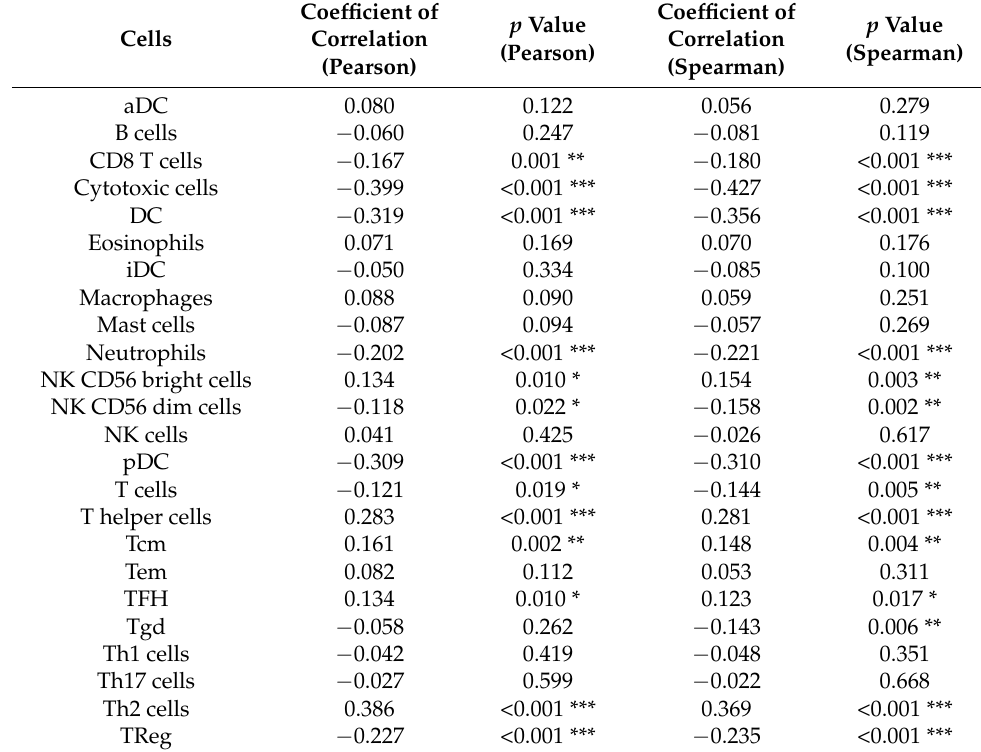
Table 5. Correlation analysis between POGK and immune cells in GEO dataset.